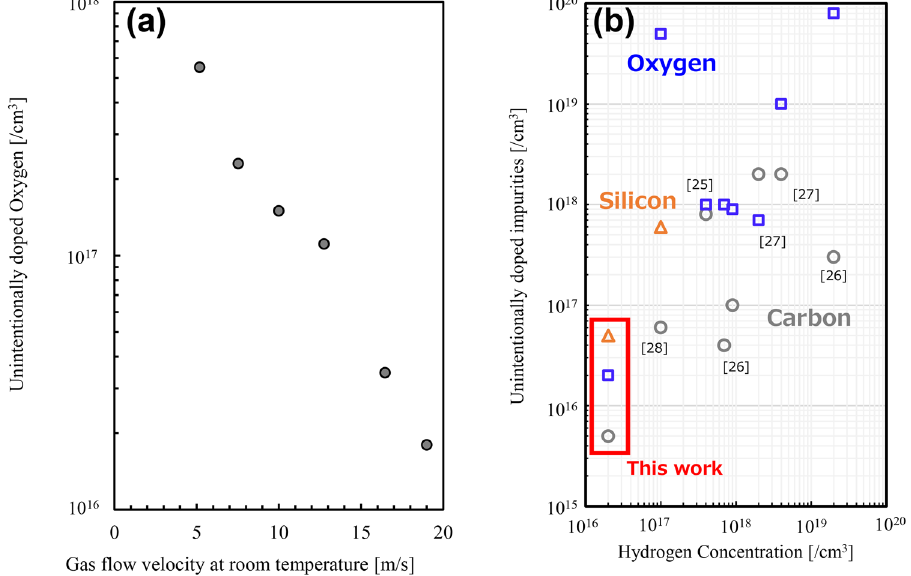
Figure 5. The impurity concentrations ingrown AlN. ( a ) Oxygen admixture concentration in the AlN measured using secondary ion mass spectrometry (SIMS) as the function of gas flow velocity grown under fixed growth temperature of 1500 °C. This figure demonstrates the efficiency of increasing gas flow for the reduction of oxygen concentration. The data were obtained at a depth of around 500 nm below the crystal surface; ( b ) Comparison between the best data impurity concentrations measured by SIMS obtained in this work compared to those reported in the literature 25–28